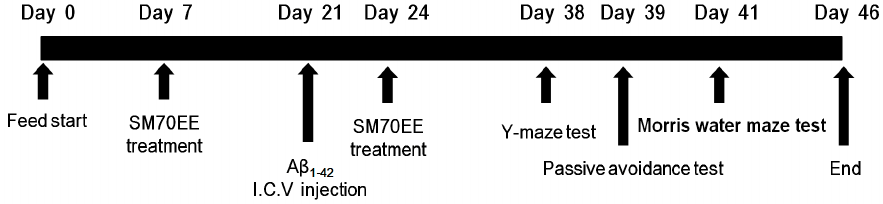
Figure 1. Experimental design. Male institute for cancer research (ICR) mice (5 weeks old) were orally administered a 70% ethanol extract of Spirulina maxima (SM70EE; 150 or 450 mg/kg/day) or an equal volume of vehicle (1.0% methylcellulose) once daily for 2 weeks. After 2 weeks, mice received an intracerebroventricular (I.C.V.) injection of A β 1–42 (400 pmol) and continued receiving the same dosage of SM70EE (or vehicle) for an additional 2 weeks. Behavioral tests were conducted after the SM70EE administration concluded.